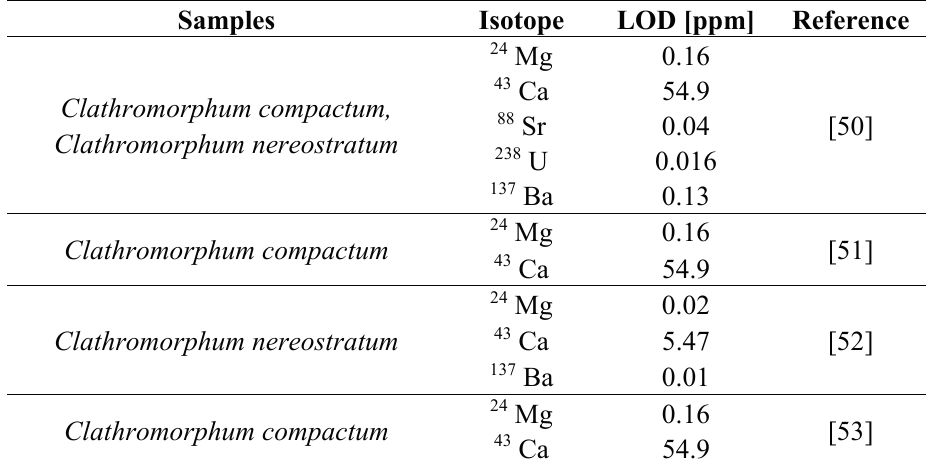
Table 2. Limits of detection (LOD) obtained by LA-ICP techniques taken from selected